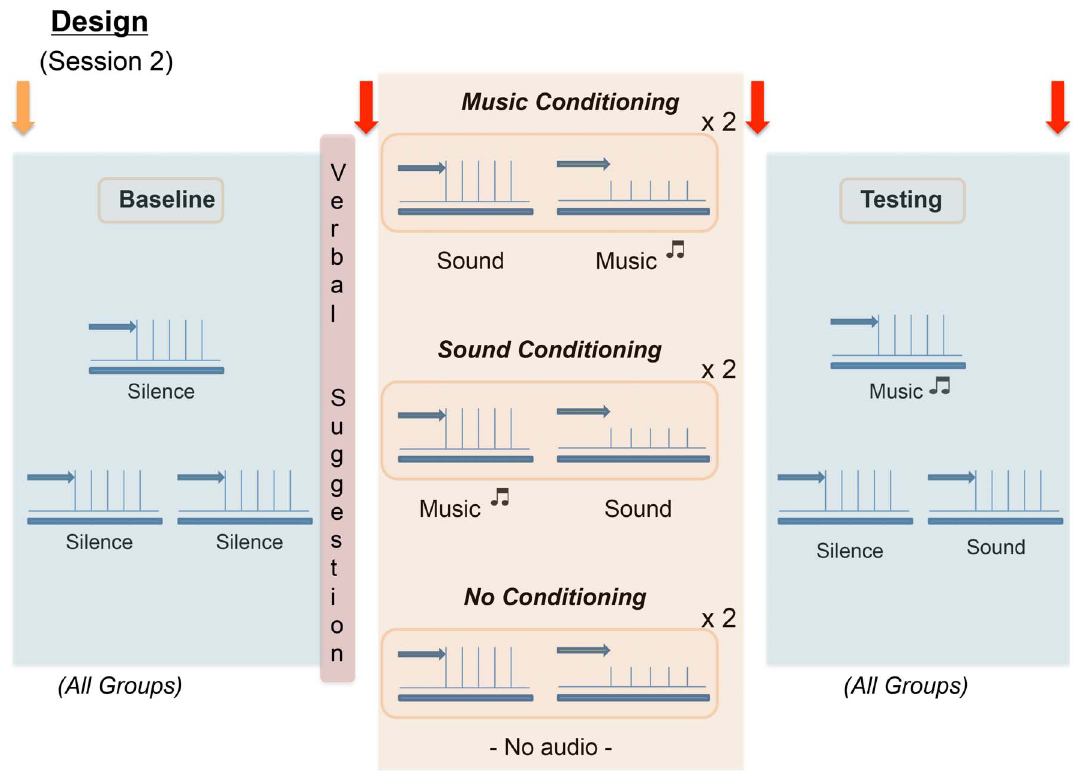
Figure 2. Schematic of Session 2. All subjects first receive identical baseline stimuli on three spots of their right arm. Conditioning groups were then given a verbal suggestion specific to their conditioned audio target, while the no-conditioning group was given a neutral suggestion. All groups then received four blocks of two stimulus intensities, with levels determined during Session 1 (target levels=20–40 out of 100 and 55–70 out of 100 on the pain intensity VAS). Conditioning groups received lower heat levels when the conditioned audio stimulus was on, while the no-conditioning group received stimuli with silence. All groups were then tested with three audio conditions: music, sound, and silence, in randomized order across participants. Within each set of trials, lead-in arrows represent 1 minute of audio or silence that preceded the start of pain stimuli. In all groups ERS was assessed right after verbal suggestion, then following conditioning/variable pain, and after testing (red arrows). We added one more baseline ERS assessment within the music conditioning replication group at the end of session 1 (orange arrow).